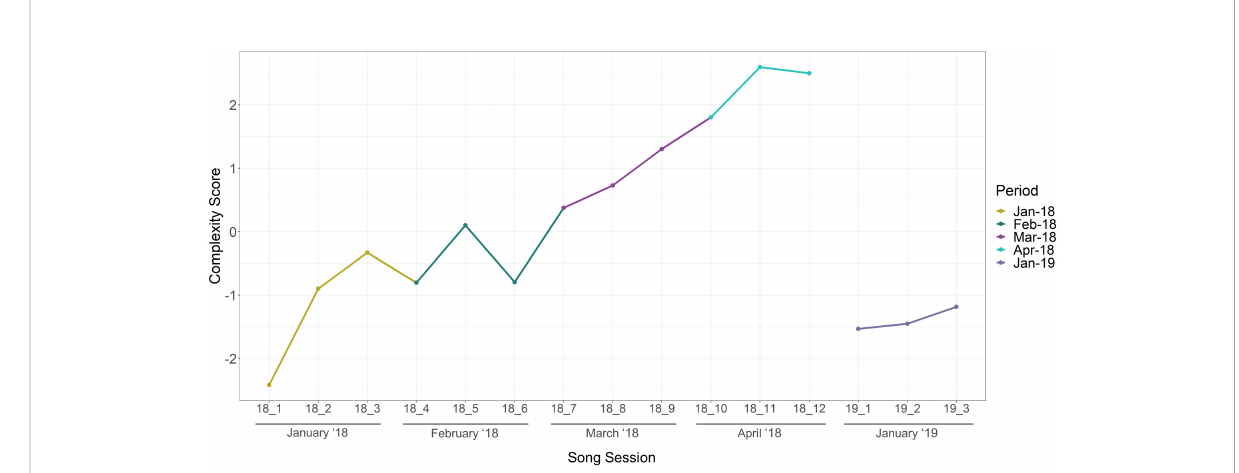
FIGURE 6 Song complexity over the study period January 2018 - January 2019. Each song session represents the average of three song cycles measured. The split in lines indicates lack of data (July-November).